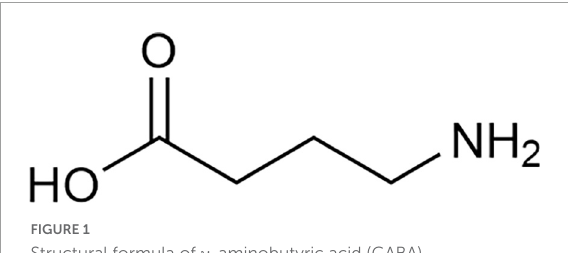
FIGURE1 Structural formula of γ -aminobutyric acid